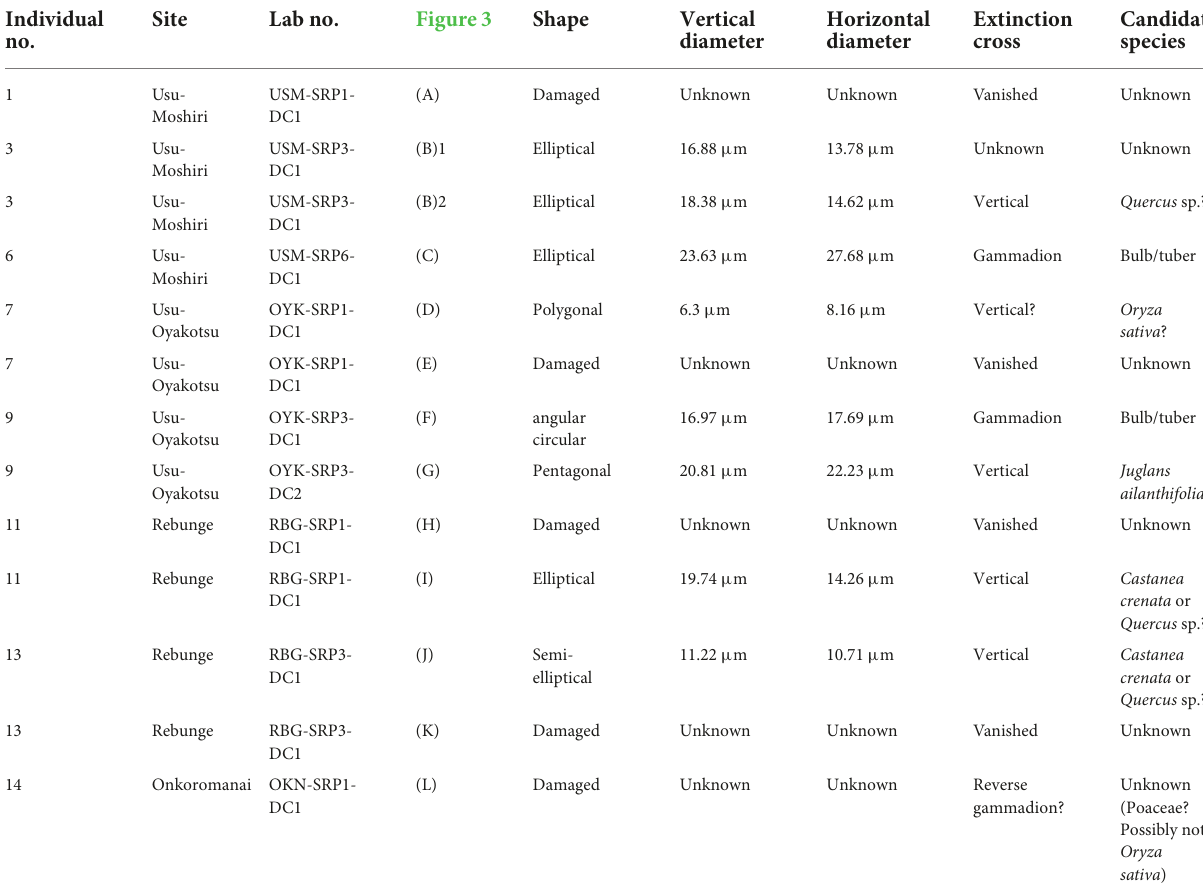
TABLE 2 Extracted starch granules from dental calculus samples. Individual